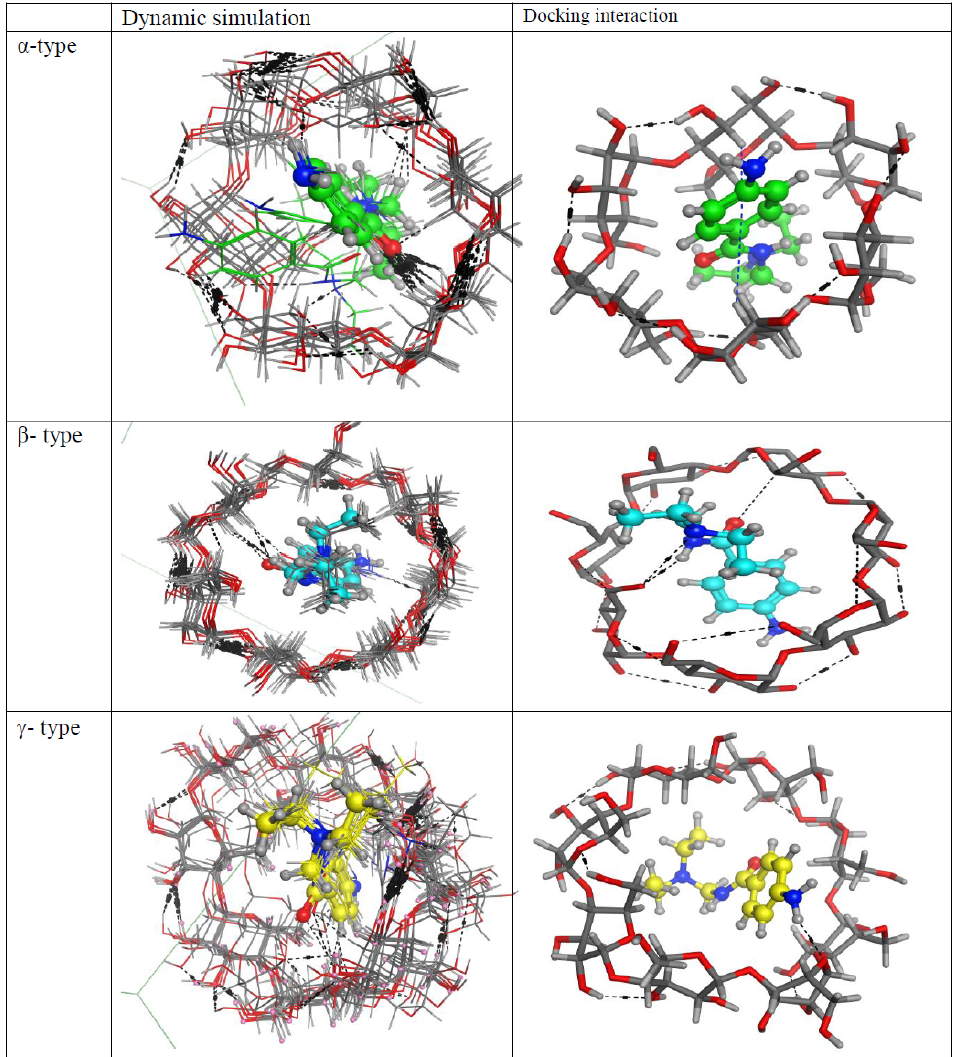
Figure 6: Structure of procainamide and α-, β-, or γ-CD inclusion complex.